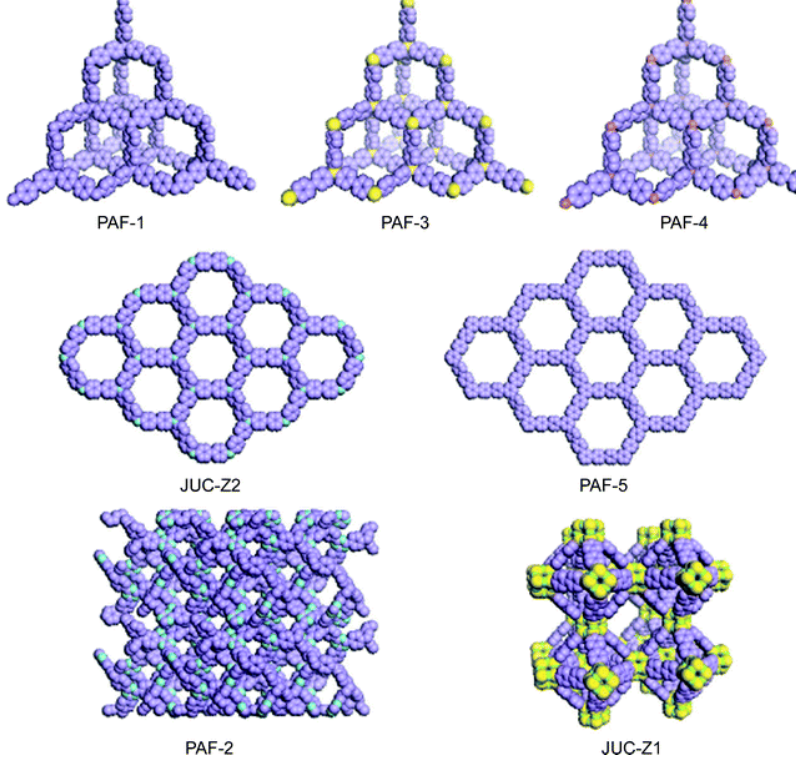
Figure 8. Structure model of synthesized and simulated porous aromatic frameworks. Atom colors: C = purple, N = blue, Si = yellow, O = green, Ge = brown [134], with copyright permission from © 2012, Royal Society of Chemistry.